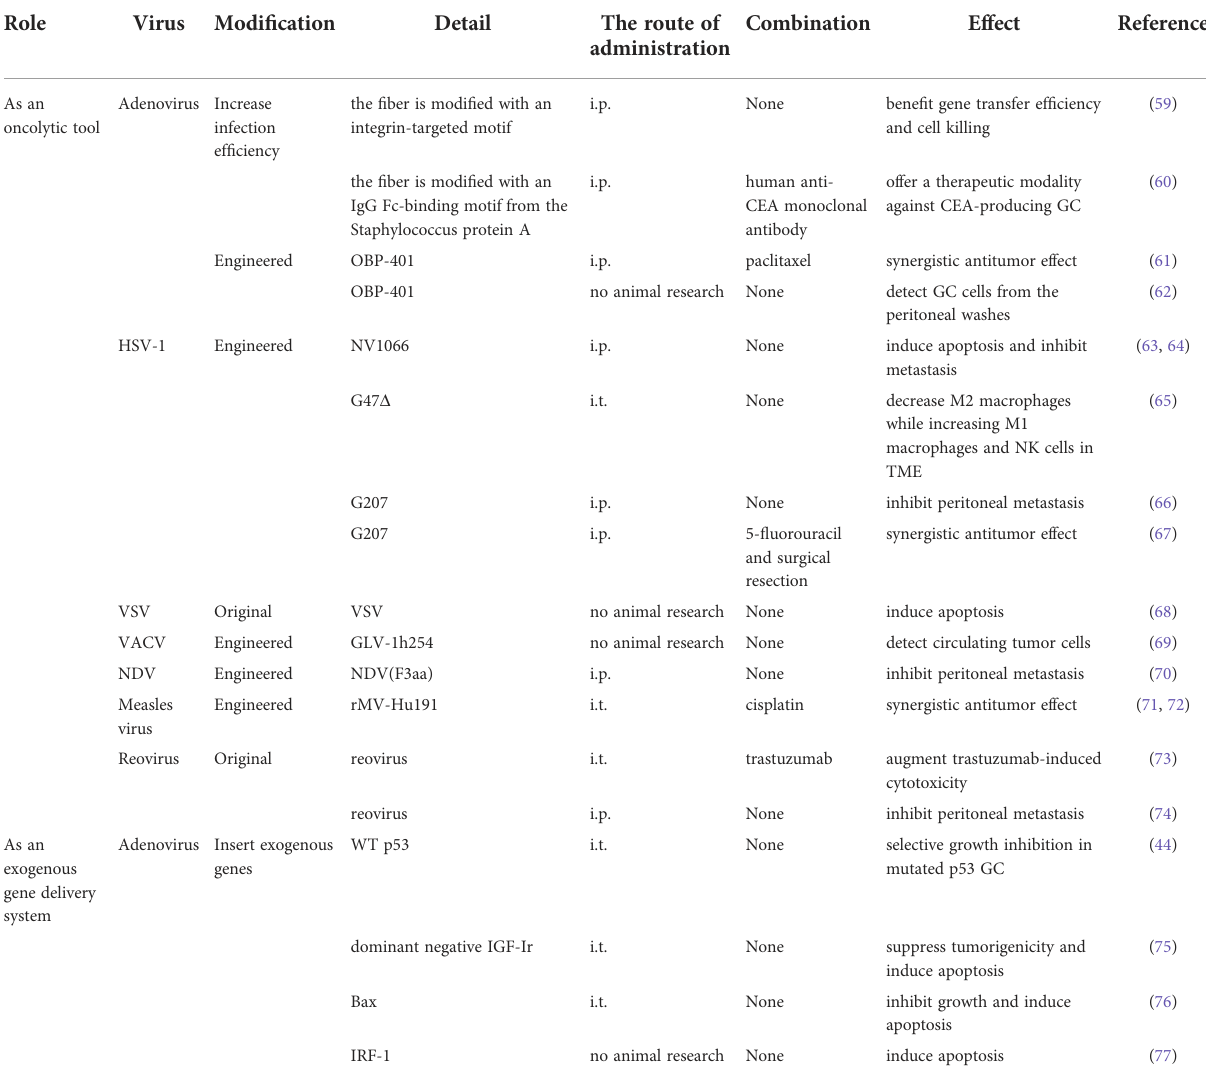
TABLE 1 Studies of various OVs for the treatment of GC. Role Virus Modi fi cation Detail The route of